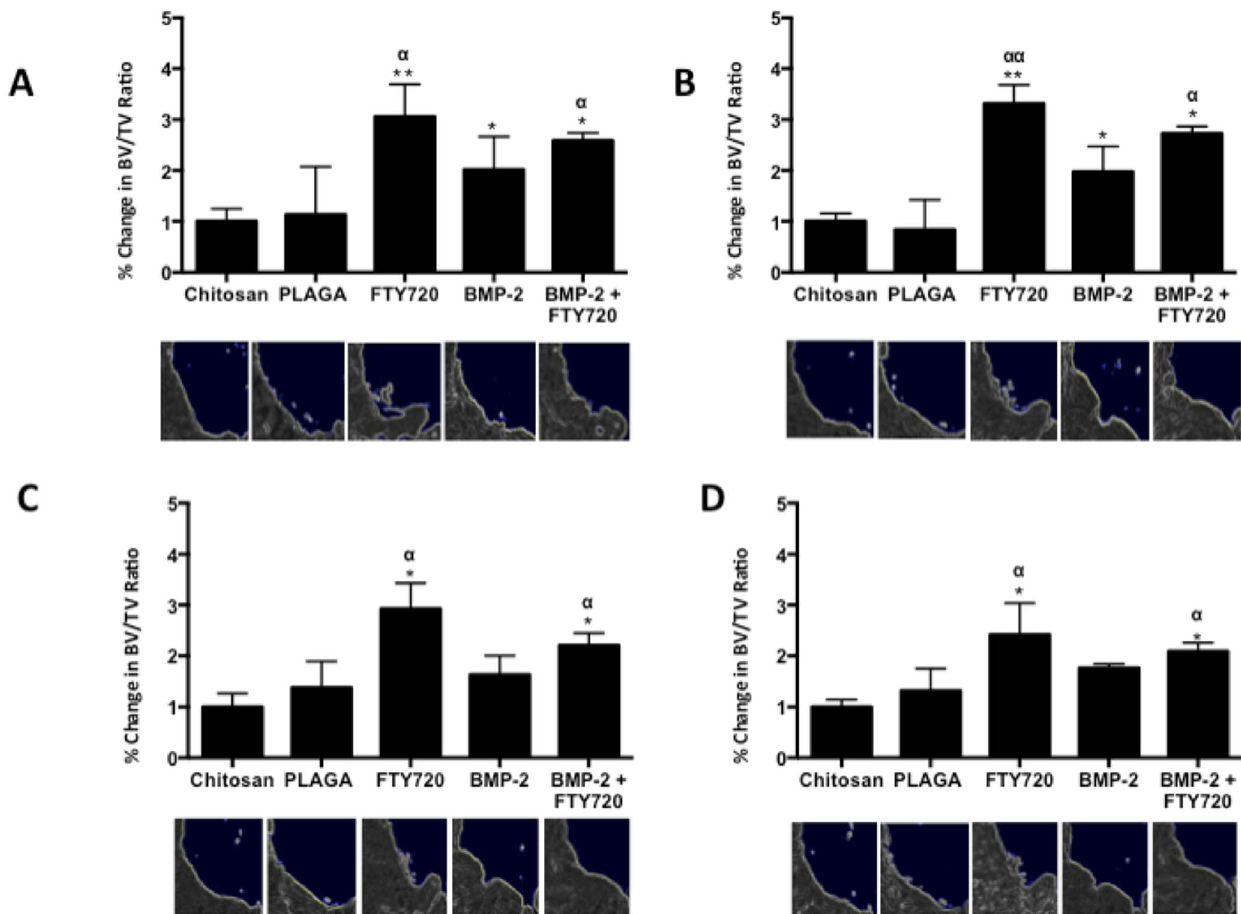
Figure 4. Bone growth in the critical size cranial defect measured using microCT. The ratio of bone volume (BV) to total volume (TV) of the region analyzed by microCT indicates the cumulative amount of new bone formed at (A) Week 2, (B) Week 4, (C) Week 6 and (D) Week 9 after implantation (** p , 0.01 & *p , 0.05 compared to chitosan control; aa p , 0.01 & a p , 0.05 compared to PLAGA control at similar time points). Representative images of a quadrant of the defect site are shown at each time point (White dashed lines indicate original defect, white arrows indicate new bone formation.